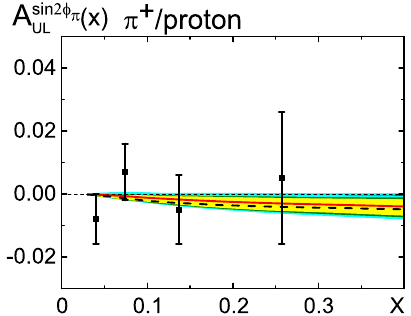
φ h Fig. 3 The A sin2 asymmetryforthe π + (left)and π − (right)produc- UL tions off the proton target as function of x at HERMES. The solid lines correspond to the results from the BDPRS parametrization [64] on the nonperturbative form factor, while the dashed lines correspond to the results calculated from the EIKV parametrization [62] on the nonper-